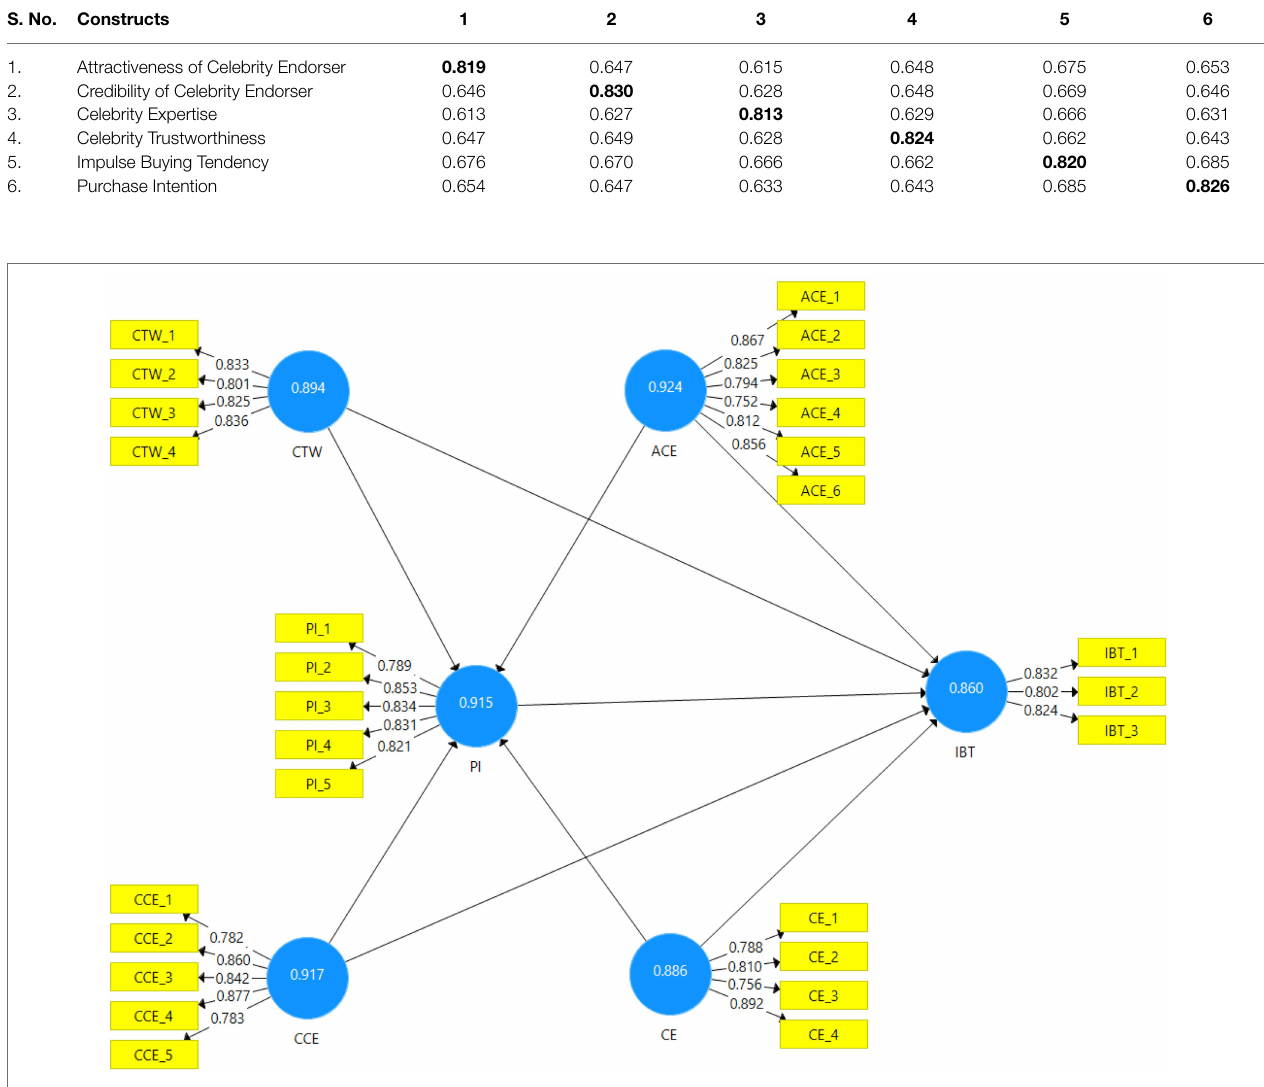
FIGURE 2 | Graphical representation of assessment of measurement model.